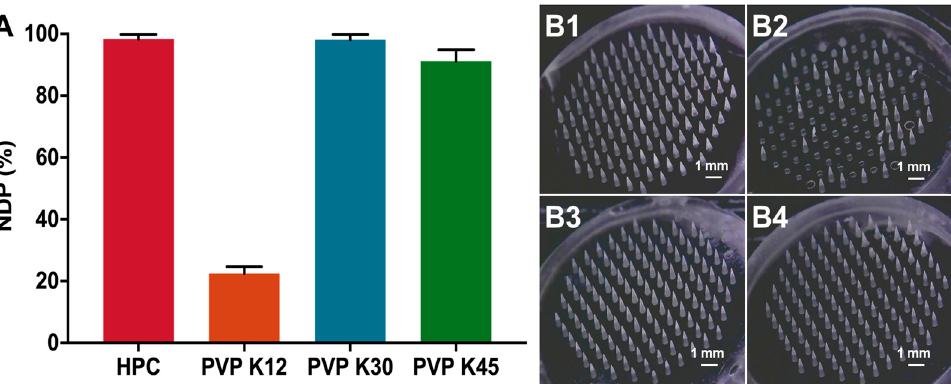
Figure 5. The in fl uence of polymers used as needle skeleton materials on the ( A ) DNP ( n = 3) and ( B ) morphology of particle-embedded gas-propelled MNs: ( B1 ) HPC, ( B2 ) PVP K12, ( B3 ) PVP K30, and ( B4 ) PVP K45.